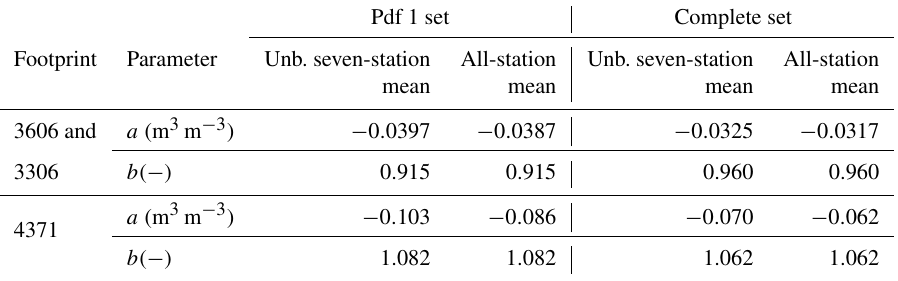
Table 4. Upscaling parameters, a and b, calculated by applying Eqs. (5) and (6), respectively, to the complete data and a set representing pdf 1 with the unbiased seven-station mean and the all-station mean as references. The pdf 1 set holds 828 and 747 samples for footprints 3606, 3306, and 4731, respectively, and the complete set includes 1146 and 1003 samples, respectively. Pdf 1 set Complete set Footprint Parameter Unb. seven-station All-station Unb. seven-station All-station mean mean mean mean 3606 and a (m 3 m − 3 ) − 0 . 0397 − 0 . 0387 − 0 . 0325 − 0 . 0317 3306 b( − ) 0.915 0.915 0.960 0.960 a (m 3 m − 3 ) − 0 . 103 − 0 . 4371